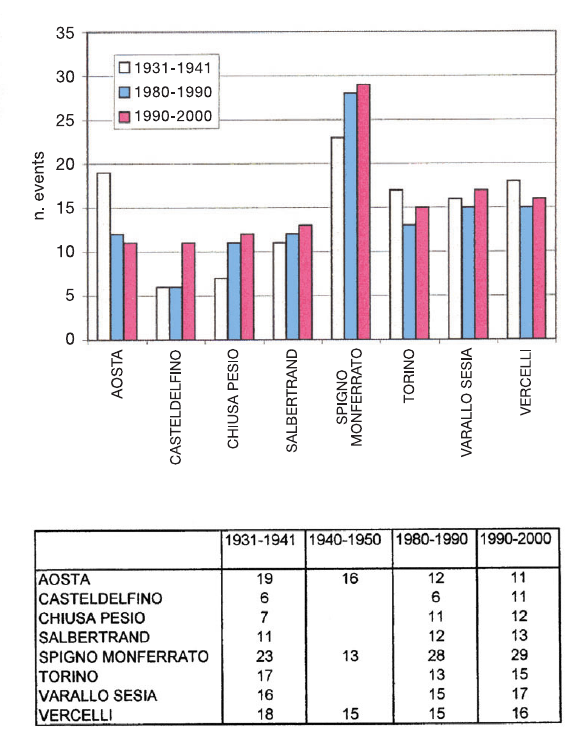
Fig. 3. Number of events of 24 h with NII different from 0.